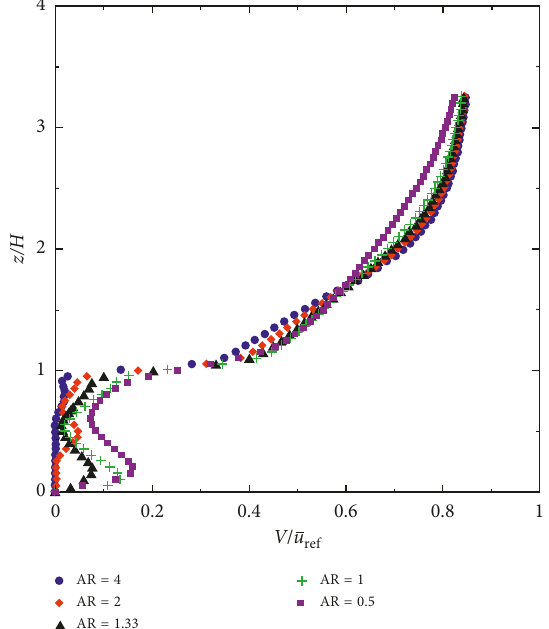
Figure 10: Comparison among the simulated vertical profiles of V/u ref passing through the center of the canyon for AR (cid:31) 4, AR (cid:31) 2, AR 1.33, AR 1, and AR (cid:31) (cid:31) (cid:31)